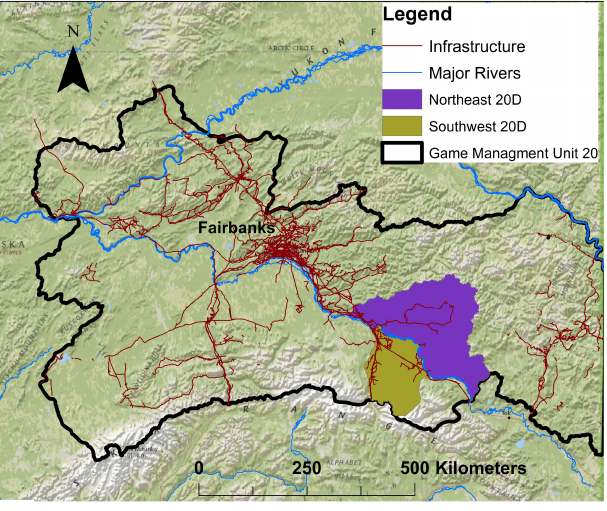
Fig. 4 . Map of transportation infrastructure including all